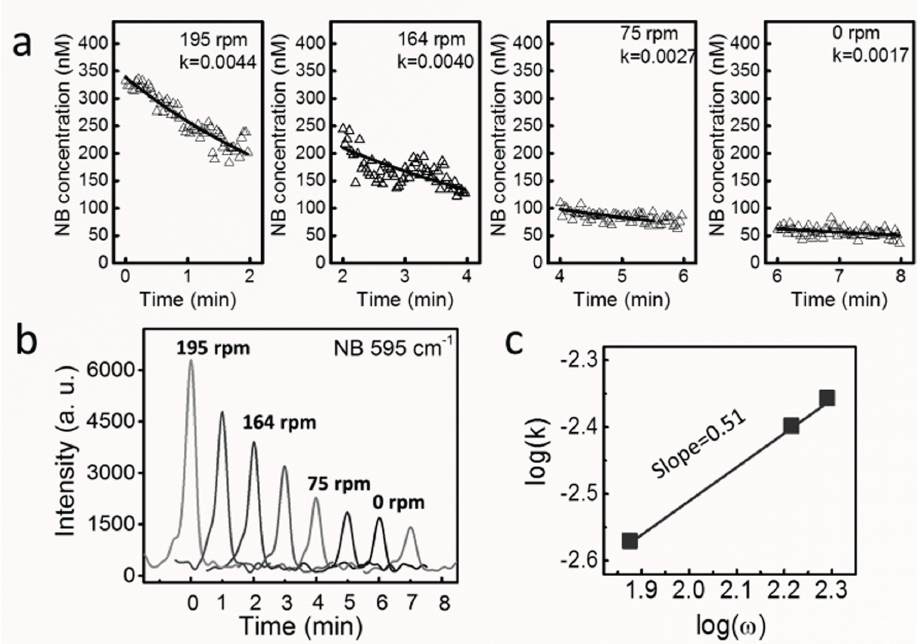
Figure 17. Tunable release of NB molecules by the mechanical rotation of nanomotor sensors. ( a ) Time dependent concentration of NB at various rotation speeds; ( b ) Raman spectra of R6G every 1 min at each rotation speed; ( c ) The power law dependence